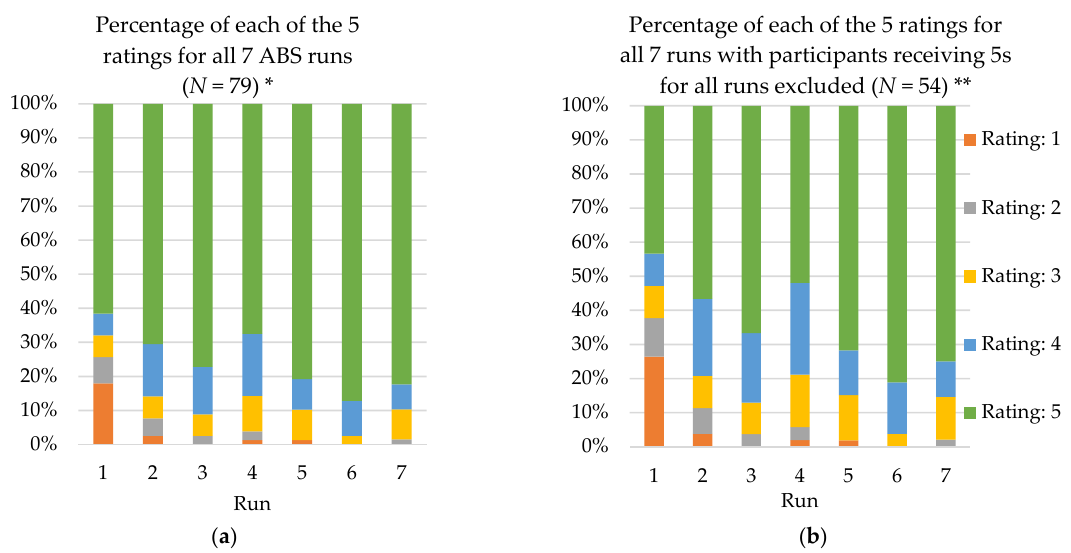
Figure 4. ( a ) The percentage of 1–5 instructor ratings for the 7 runs for all 79 participants ( b ) The percentage of 1–5 instructor ratings for the runs without the 25 participants who received a perfect instructor rating of 5 for all runs in ( a ), * Runs 1–6 fluctuated slightly between 77–79 participants due to data collection errors, run 7 had 68 participants due to time limitations. ** Runs 1–6 fluctuated between 52–54 participants due to data collection errors, run 7 had 48 participants due to time limitations.